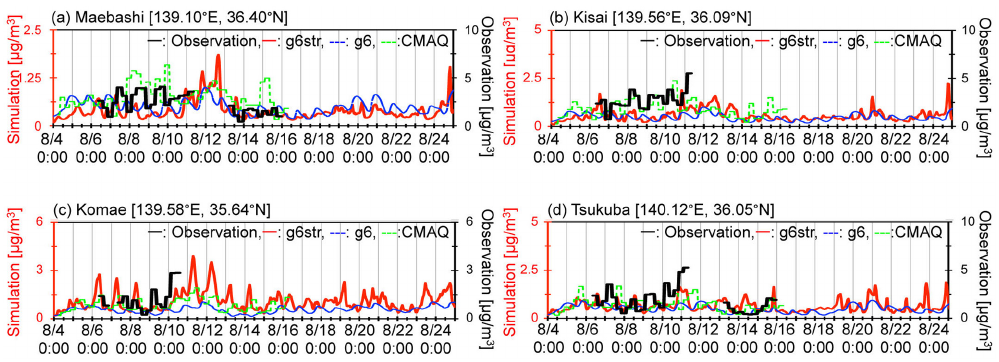
Figure 11. Temporal variations in the simulated (NICAM-g6str, NICAM-g6, and WRF-CMAQ) and observed EC mass concentrations near the surface at (a) Maebashi, (b) Kisai, (c) Komae and (d) Tsukuba in August 2007. The WRF-CMAQ results are given by Shimadera et al. (2013). The left axis in red represents the simulated values, and the right axis in black represents the observed values, in units of µgm 3 .